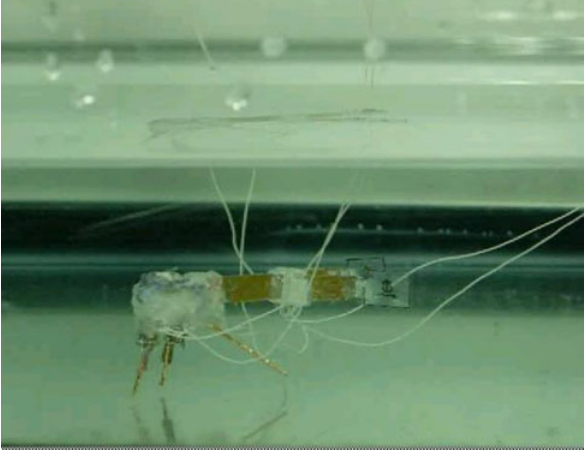
Figure 13 Measurement system of propulsion.